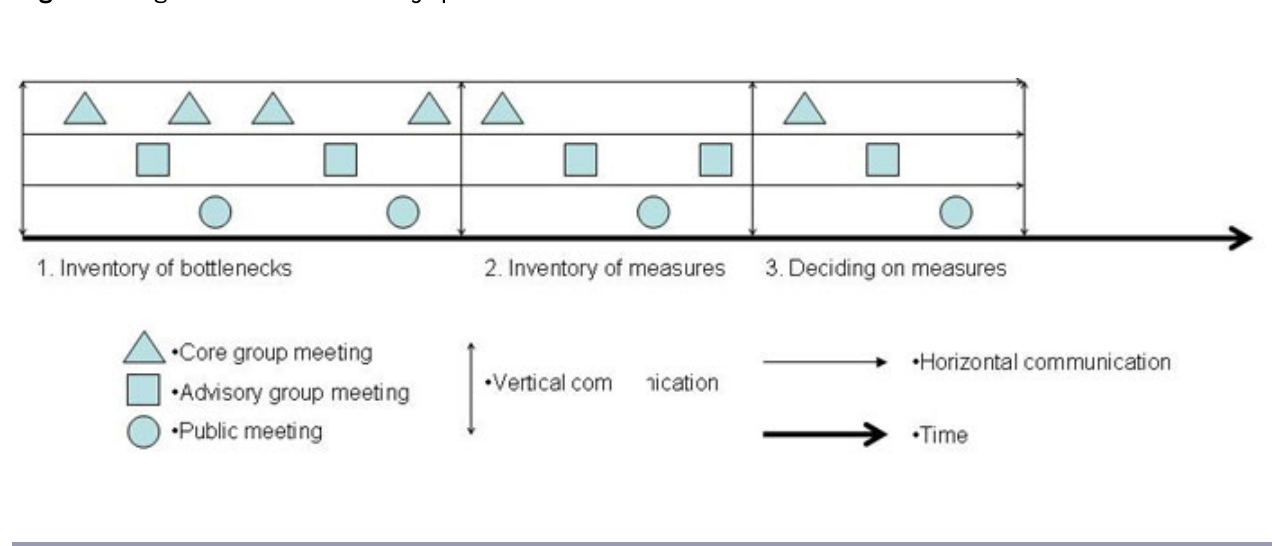
Fig. 2. Design of the Kromme Rijn